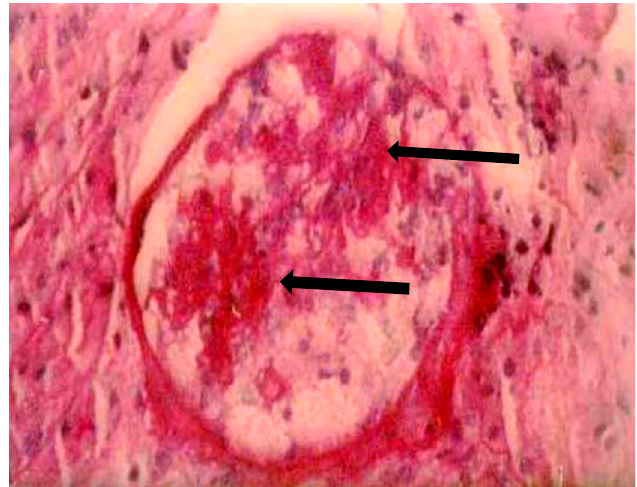
Figure 1. Patient 1, kidney biopsy. Presence of positive PAS material, which totally or partially occludes capillary lights (arrows).